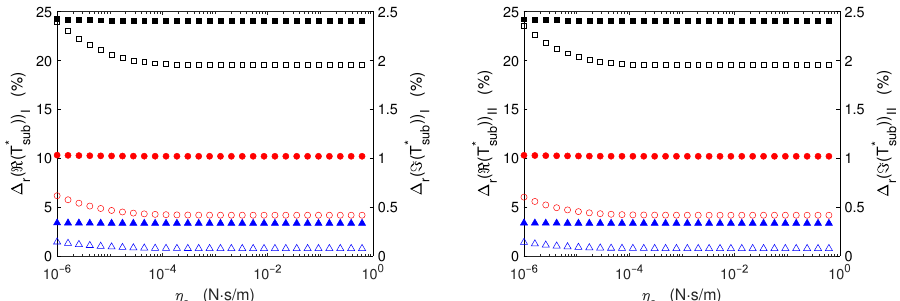
Figure 5. Subphase drag torque relative differences between the solutions with different mesh sizes )) (solid symbols), taking as a reference the 2520 × 1260 mesh solution for the real part, ∆ r ( (cid:60) ( T ∗ sub )) (open symbols). Black symbols: 200 × 100 mesh. Red symbols: and the imaginary part, ∆ r ( (cid:61) ( T ∗ sub 440 × 220 mesh. Blue symbols: 1000 × 500. Left panel: program version (PV)-I, right panel: PV-II. The results obtained for subphase drag with versions I and II of the program show